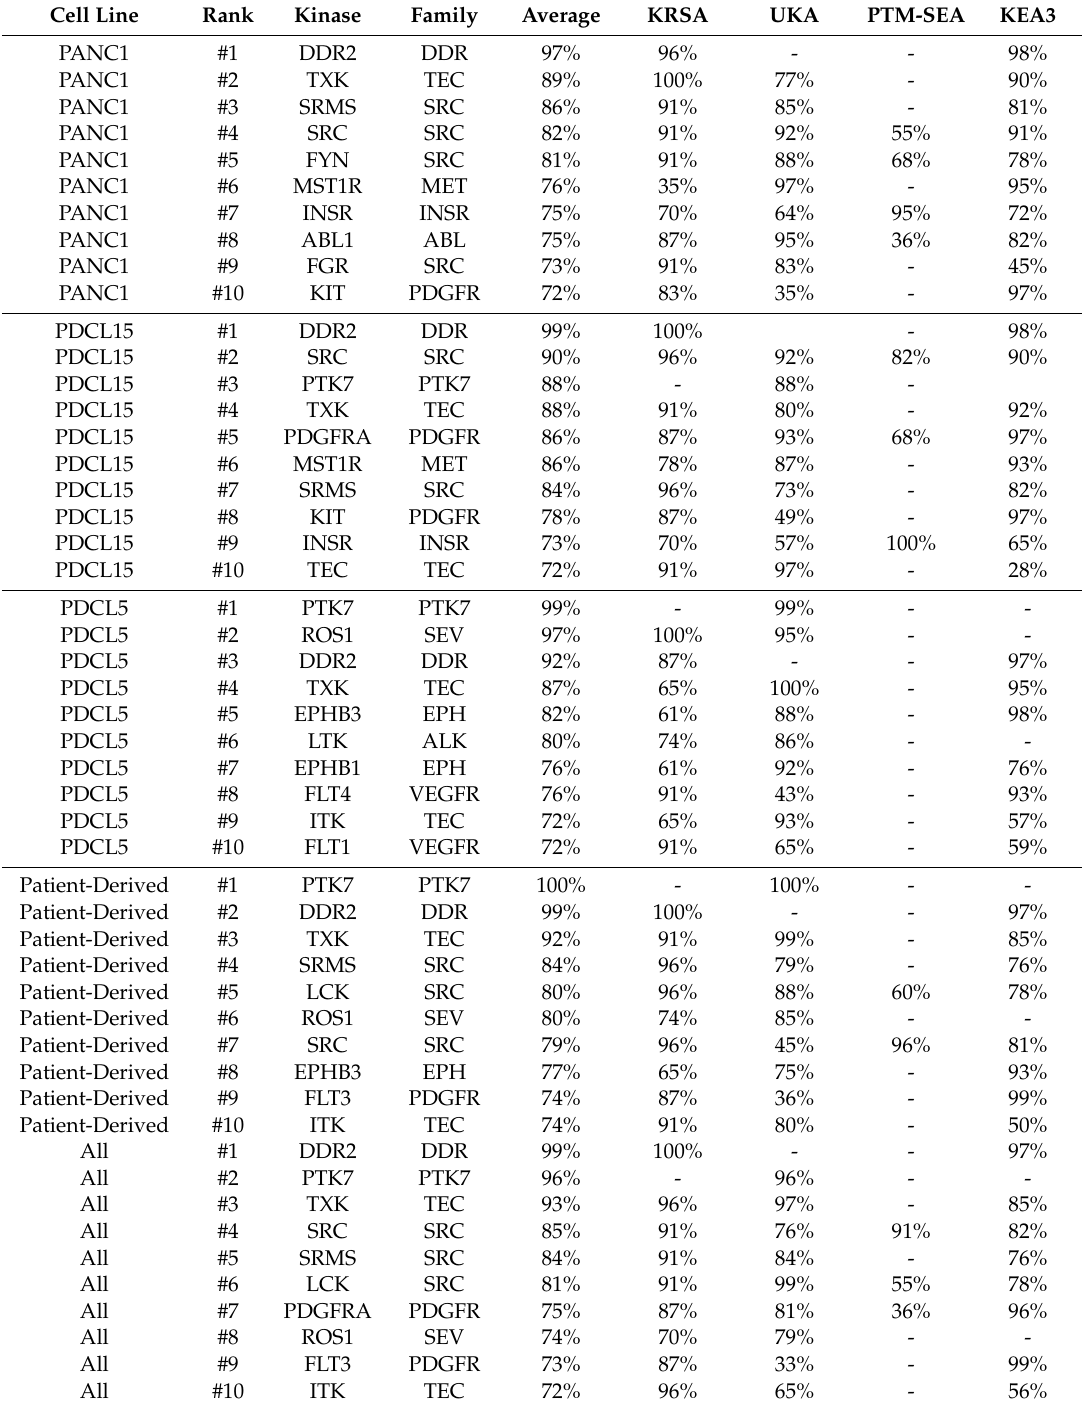
Table 3. All pipelines’ (KRSA, UKA, PTM-SEA, and KEA3) average percentile